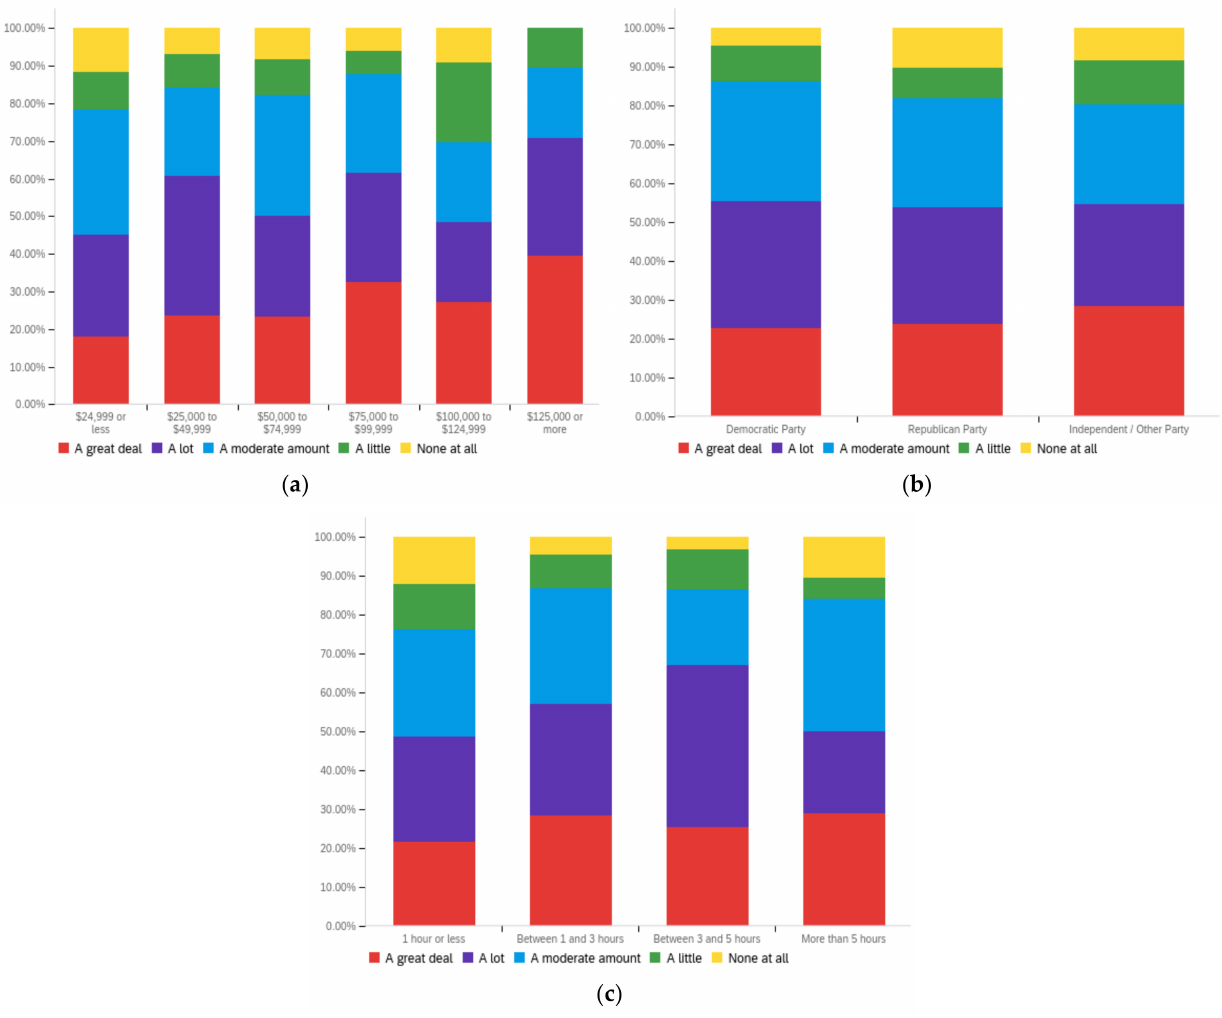
Figure A17. Article author’s political alignment—others’ perception impact by: ( a ) income level (top left), ( b ) political affiliation (top right) and ( c ) online usage